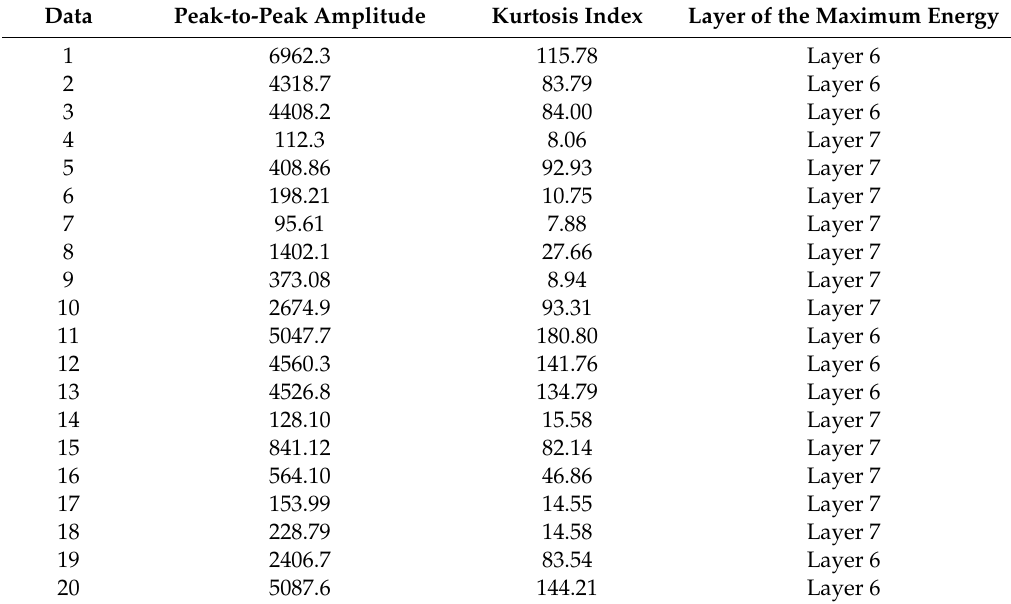
Table 1. The characteristic indexes of the target signal.